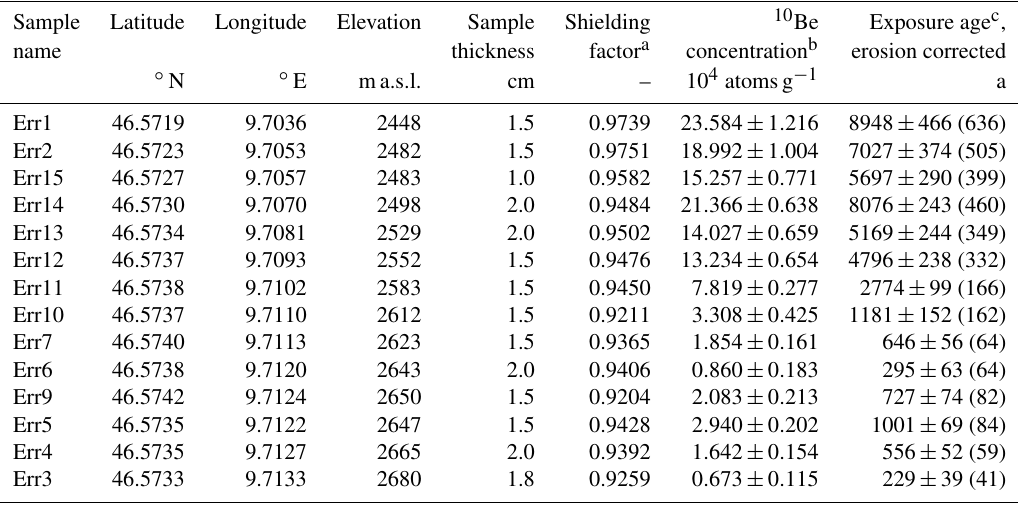
Table 1. The 10 Be sample information of the Bleis Marscha rock glacier boulders (Err Granodiorite) with location, sample information, blank-corrected AMS 10 Be concentration, and calculated exposure age.